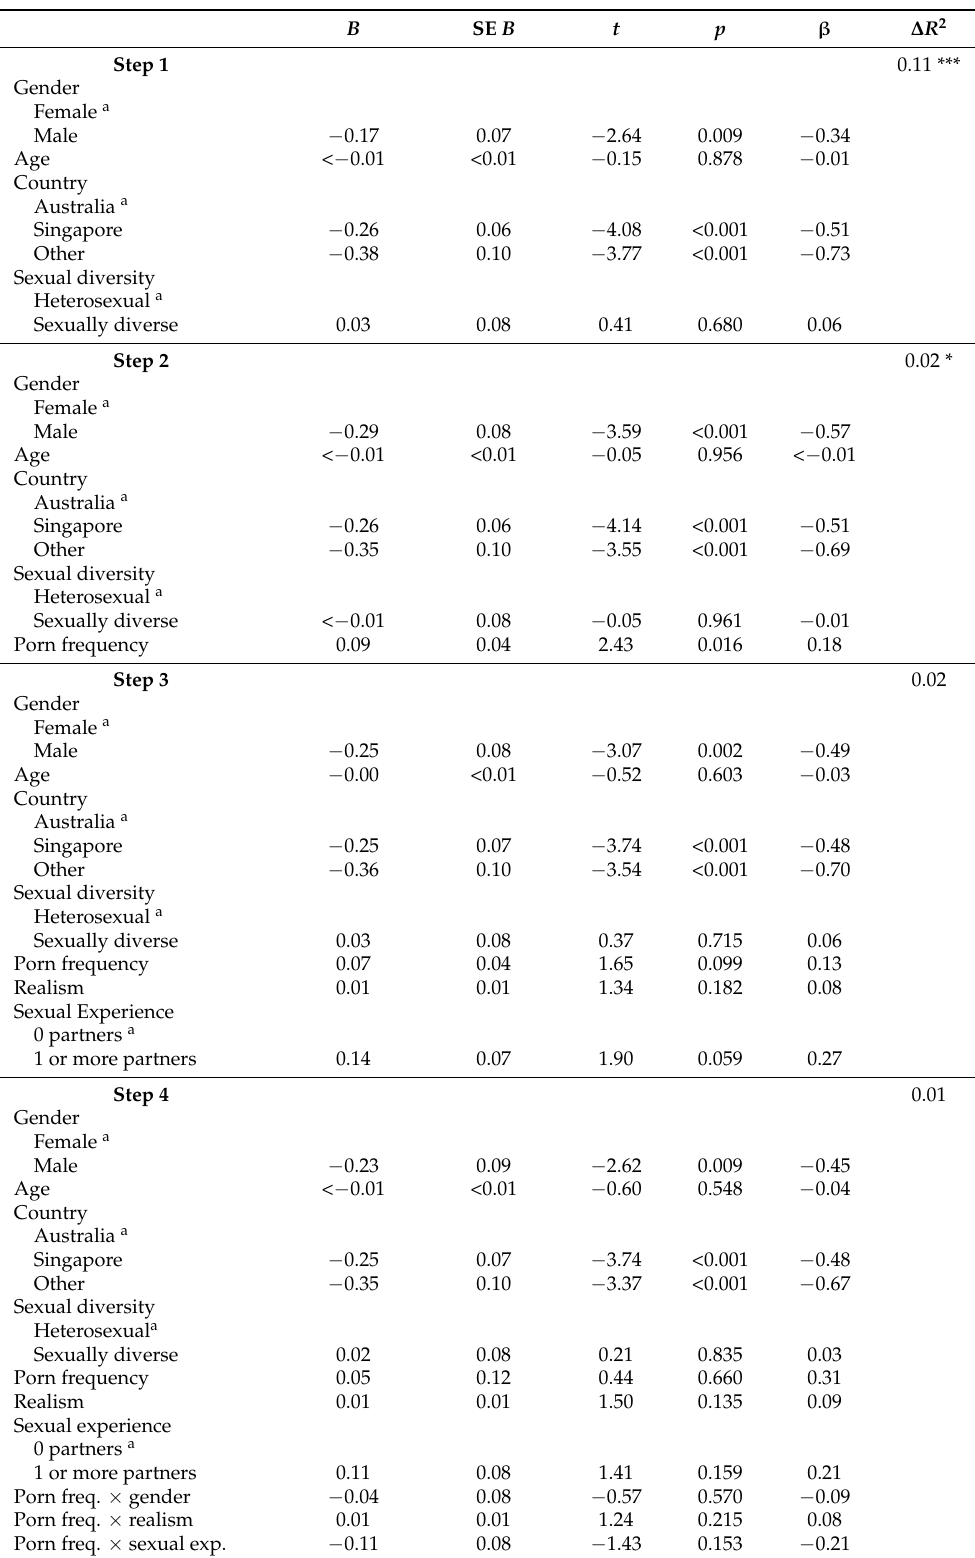
Table 4. Hierarchical multiple regression analysis predicting porn-congruent sexual health